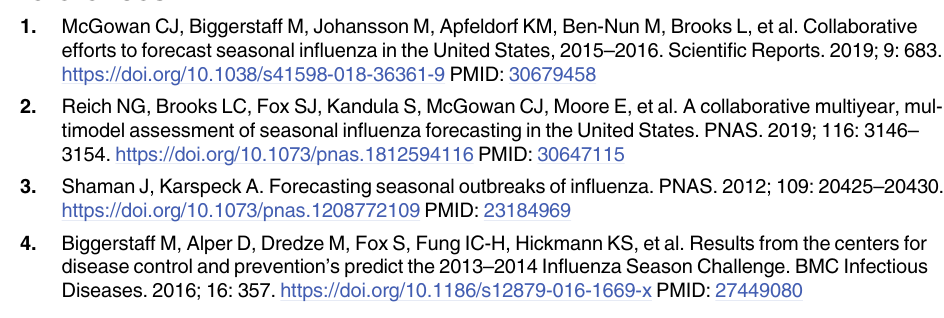
S23 Fig. Number of participants who submitted a forecast over time. (TIF) S24 Fig. Number of member models in the official Hub ensemble. This includes our crowd forecasts and the renewal model. Note that the renewal model was not included in the ensem- ble on December 28th 2020. (TIF) S25 Fig. Crowd forecasts and baseline shown in the application for a two week horizon. Shown are the median, as well as the 50% and 90% prediction intervals (in order of decreasing opacity). For any given point in time, the baseline shown in red is what forecasters saw when they opened the app (the baseline shown was constant across all forecast horizons). (TIF) S1 Acknowledgements. Members of the CMMID COVID-19 working group.